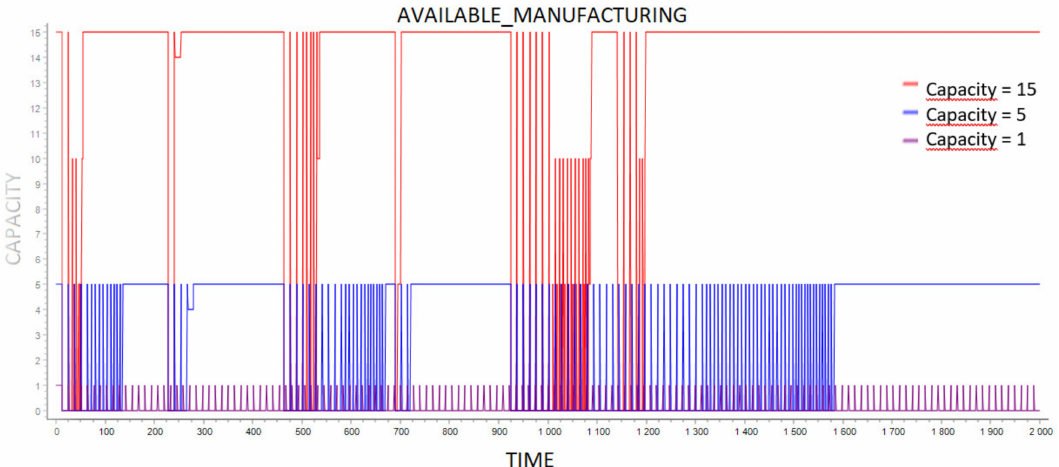
Figure 9. System sensitivity test. Source: own elaboration. Evolution software.